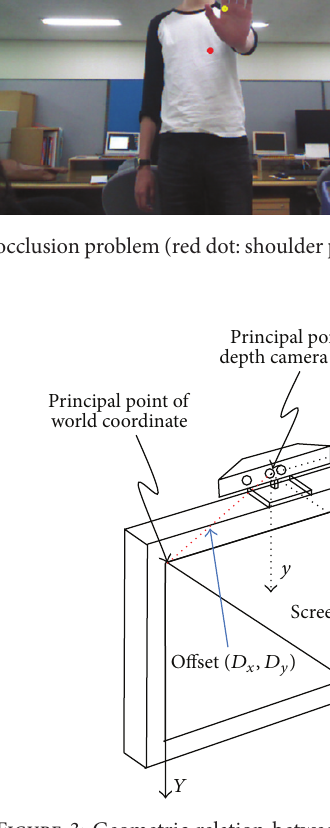
Figure 3: Geometric relation between the world coordinates and depth camera coordinates